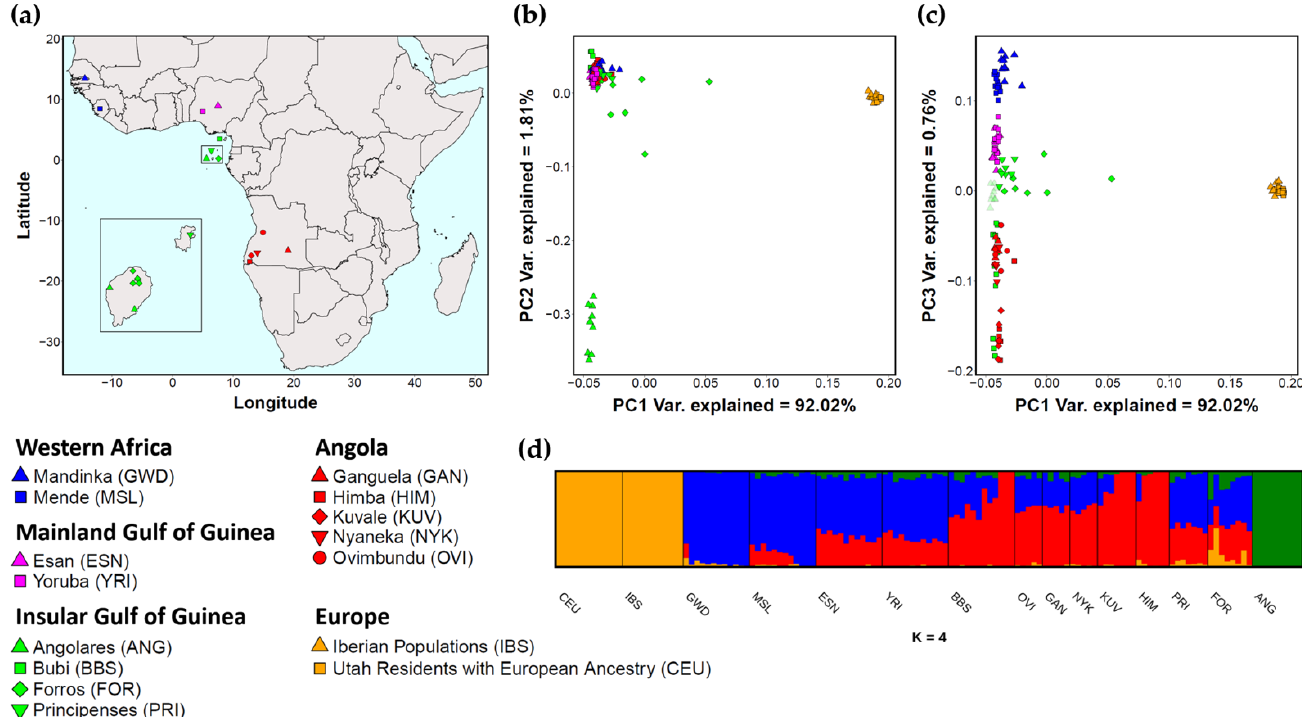
Figure 1. Genetic structure in groups from São Tomé and Príncipe in relation to European and mainland African populations. ( a ) Geographic locations of sampled individuals from São Tomé and Príncipe, and populations on the African continent. In the inset, the distance between São Tomé (larger island) and Príncipe (smaller island) is not to scale. ( b , c ) Haplotype ‐ based principal component analysis performed with CHROMOPAINTER/fineSTRUCTURE; ( b ) PC1 and PC2 plot; ( c ) PC1 and PC3 plot. ( d ) ADMIXTURE analysis assuming 4 clusters (K). Each individual is represented as a vertical line divided according to the proportion of its genome that is derived from the assumed genetic clusters. Although the lowest cross ‐ validation error (CV) was associated with K = 2, the differentiation between African mainland populations is evident only from K = 4. Additional PCA and ADMIXTURE plots are shown in Supplementary Figures S2 and S3.